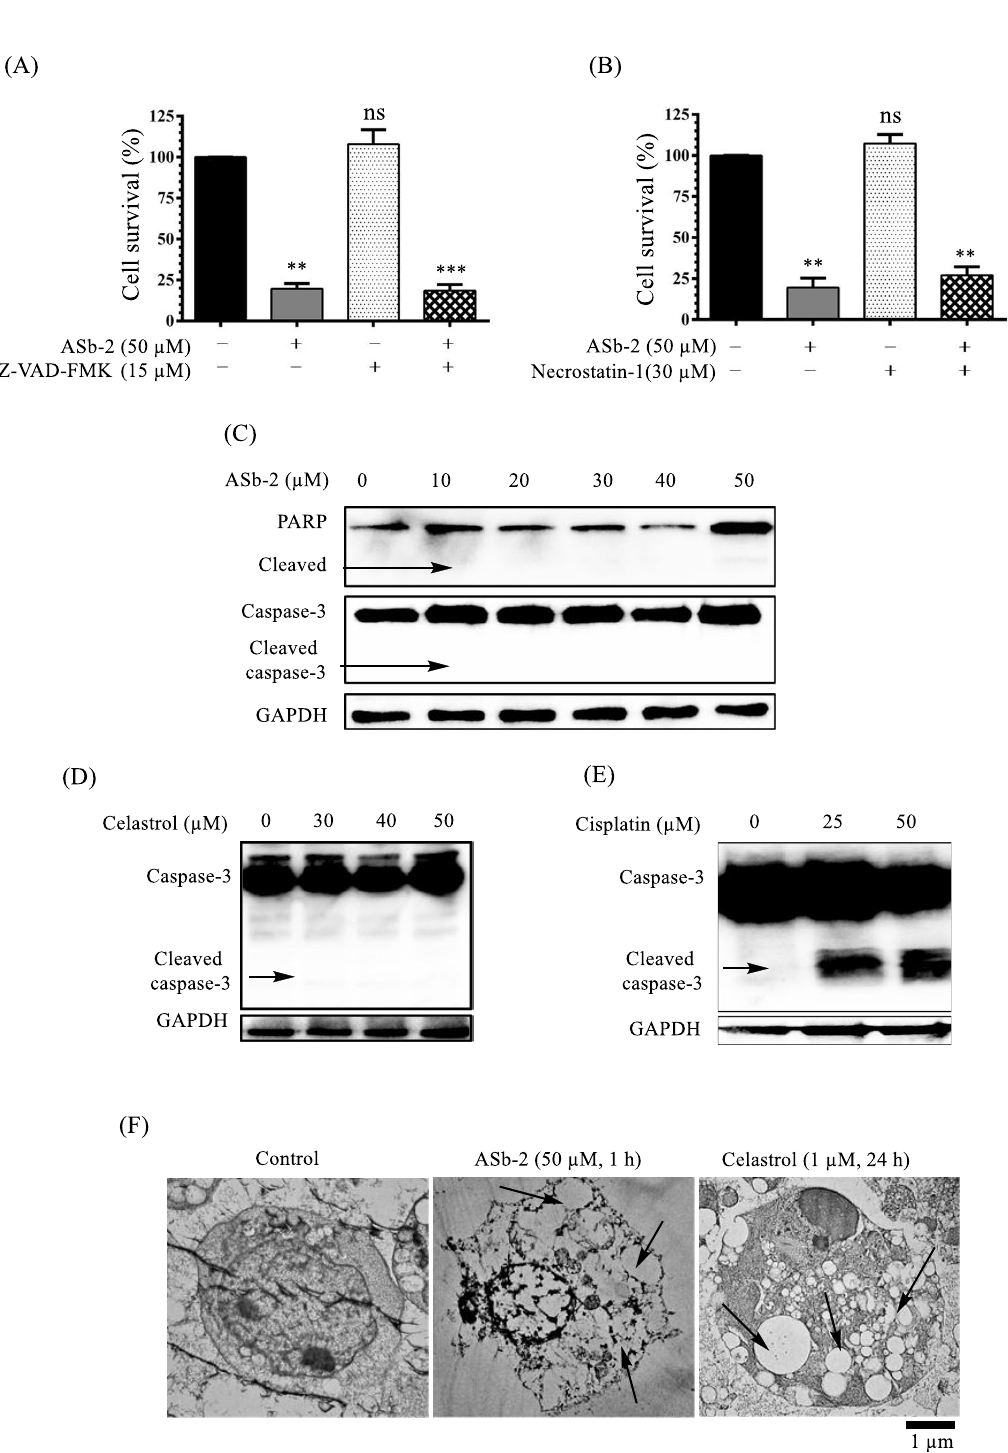
Figure 4. ( A ) The results of MTT assays of Jurkat cells treated with ASb-2 (50 µM) in the presence of Z-VAD-FMK (15 µM) (a broad caspase inhibitor) for 1 h at 37 °C. ( B ) The results of MTT assays of Jurkat cells with ASb-2 in the presence of necrostatin-1(30 µM) (a necroptosis inhibitor) for 1 h at 37 °C. ( C – E ) Western blot analysis of apoptosis-related proteins in Jurkat cells treated with ASb-2, celastrol, and cisplatin, respectively. ( F ) TEM images of Jurkat cells after the treatment with ASb-2 (50 µM, 1 h) and celastrol (30 µM, 24 h) at 37 °C. Arrows indicate cytoplasmic vacuolization in Jurkat cells induced by ASb-2 and celastrol, respectively. ** p < 0.01 and *** p < 0.001 indicate the significant differences from the control. ns: not significant (the statistical data in Figure 4A,B are listed in Table S1 in the Supporting Information). We next examined the effect of rapamycin (an mTOR inhibitor), cycloheximide (an inhibitor of protein synthesis), 2-aminoethoxydiphenyl borate (2- APB) (an inhibitor of IP₃